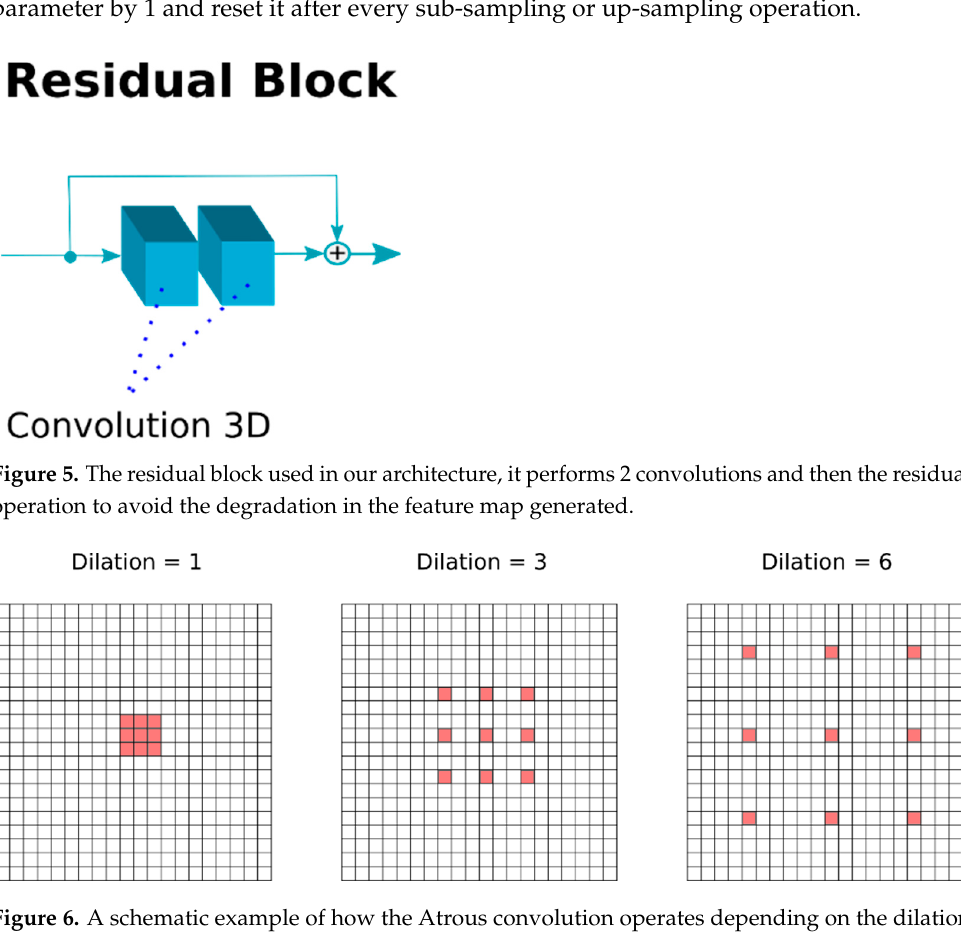
Figure 6. A schematic example of how the Atrous convolution operates depending on the dilation parameters, which determine the separation between the values selected by the kernel to perform the linear combination at each position.